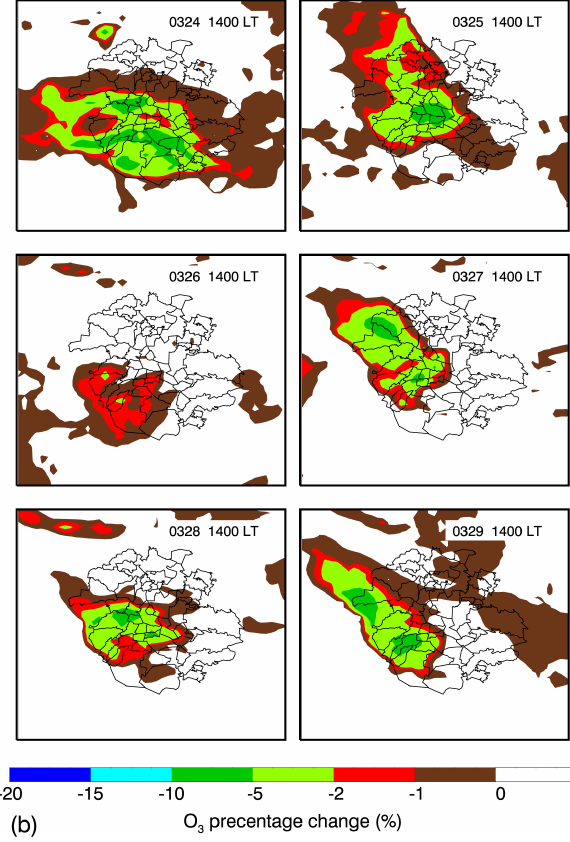
Figure 10 Fig. 10. Percentage change in surface O 3 concentrations at 10:00 and 14:00LT from 24 to 29 March 2006 when the aerosol effect on the photolysis frequencies is taken into